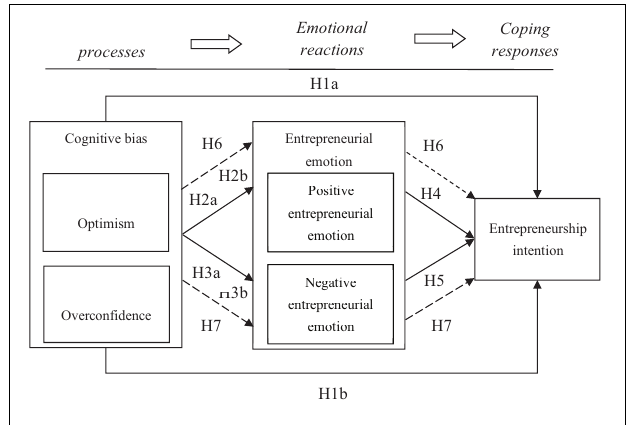
FIGURE 1 | Research model. Dashed lines indicate mediation